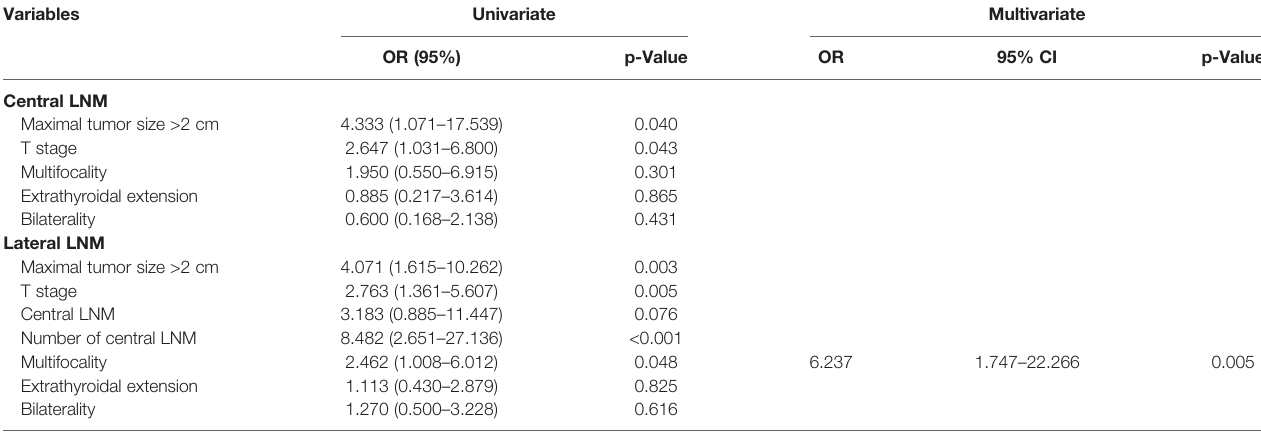
TABLE 3 | Univariate and multivariate analyses of risk factors of cervical lymph node metastases.